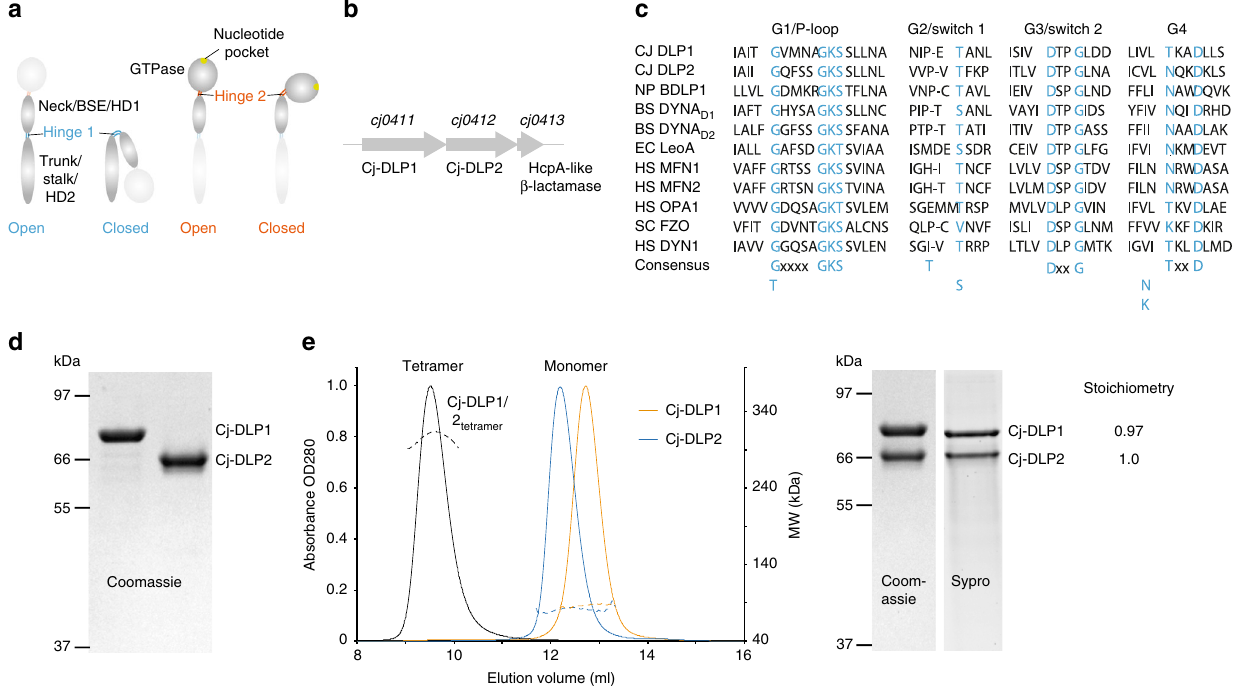
Fig. 1 Biochemical puri fi cation and characterisation of Cj-DLP1 and Cj-DLP2. a Cartoon schematic providing nomenclature for dynamin family hinge 1 and hinge 2-mediated conformations. Many dynamin family members undergo large-scale conformational changes mediated by hinges 1 and 2 at the interface of trunk/neck or neck/G-domains, respectively. b cj-dlp1 and cj-dlp2 exist as a side-by-side gene pair within an operon that putatively includes an HcpA-like β -lactamase. c Alignment of Cj-DLP1 and Cj-DLP2 G1-G4 GTP binding motifs with other members of the dynamin family. Cj-DLP1 (Uniprot accession CJ0411), Cj-DLP2 (CJ0412), Nostoc punctiforme BDLP1 (B2IZD3), Bacillus subtilis (P54159), Escherichia coli LeoA (E3PN25), human Mitofusin 1 (Q8IWA4), human Mitofusin 2 (O95140), human OPA1 (O60313), Saccharomyces cerevisiae Fzo1p (P38297), human Dynamin 1 (Q05193). Consensus sequence is highlighted in blue. d Cj-DLP1 and Cj-DLP2 purify as 84.5 kDa and 71.2 kDa proteins, respectively, as shown by SDS – PAGE. e SEC-MALS shows that Cj- DLP1 and Cj-DLP2 are monomeric in solution but form a 2:2 stoichiometric tetramer, termed Cj-DLP1/2 tetramer , when mixed (left panel). Corresponding SDS – PAGE Coomassie and SYPRO staining of Cj-DLP1/2 tetramer with stoichiometry (right